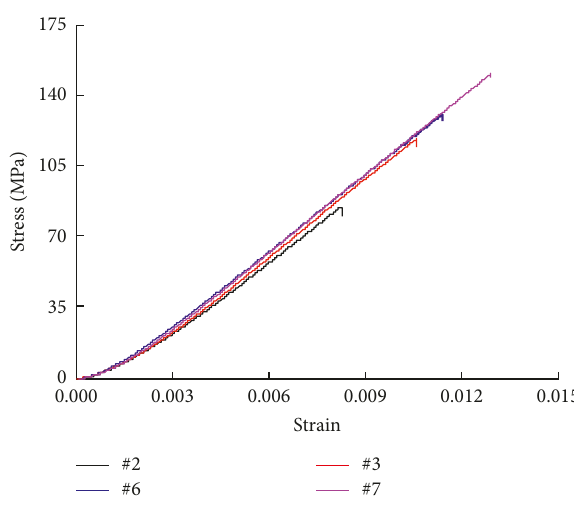
Figure 5: Stress-strain curve of Group 1 without initial damage.